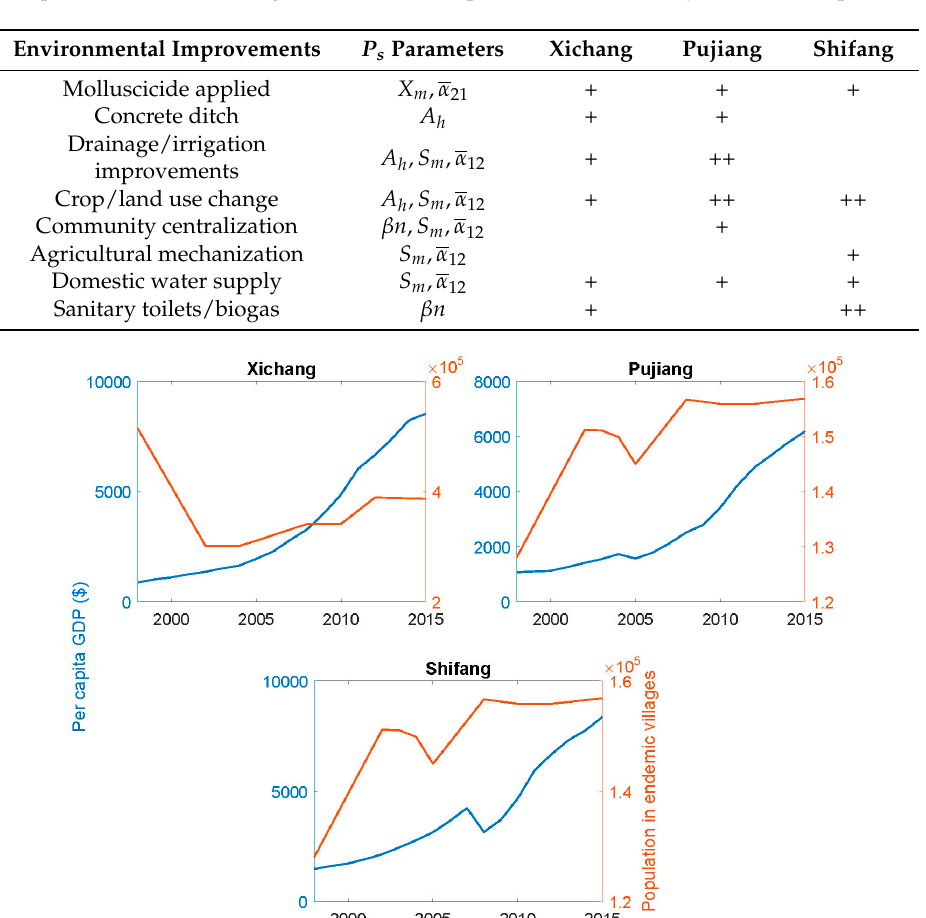
Table 2. Environmental improvements affecting determinants of the site-specific elements of the effective reproductive number governing schistosomiasis transmission in three endemic counties of Sichuan province. + indicates significant level of improvement and ++ major extent of improvement.